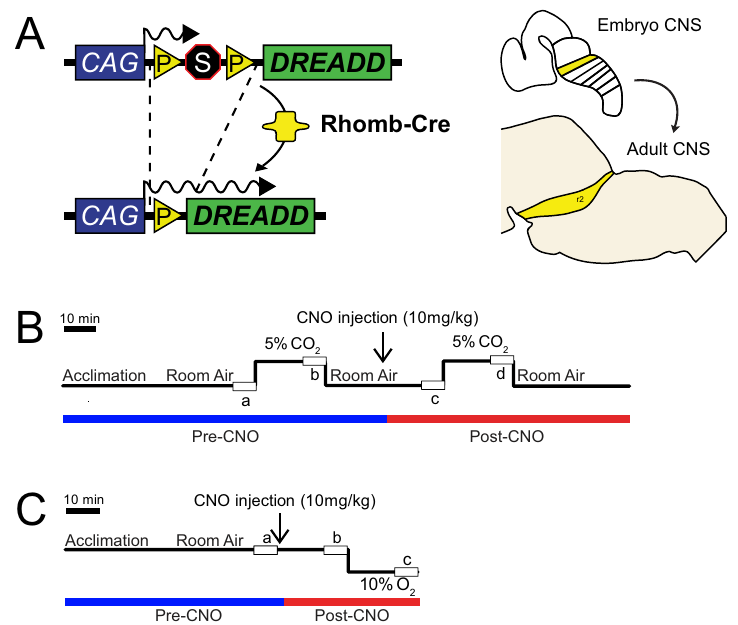
Figure 1. Breeding schematic and respiratory protocols. ( A ) The RC::P_hM4D allele is combined with 5 different rhombomere-specific-Cre lines to achieve cell specific expression of the hM4D receptor in embryonically-defined domains in the adult. Shown as an example is rhombomere 2 ( HoxA2-Cre) . ( B ) Hypercapnic respiratory protocol. The animal is placed into the respiratory chamber and allowed to acclimate under baseline room air conditions. The animal is then exposed to 20 minutes of 5% CO 2 followed by 20 minutes of room air. The animal is then injected intraperitoneally with 10 mg/kg of clozapine-N-oxide (CNO) followed by another 20 minutes of post-CNO room air, 20 minutes of 5% CO 2 , and 20 minutes of room air. ( C ) Hypoxic respiratory protocol. This protocol is similar to the hypercapnic protocol except that no pre-CNO 10% O 2 measurement is taken to avoid potential confounds of hypoxic plasticity on the post-hypoxic